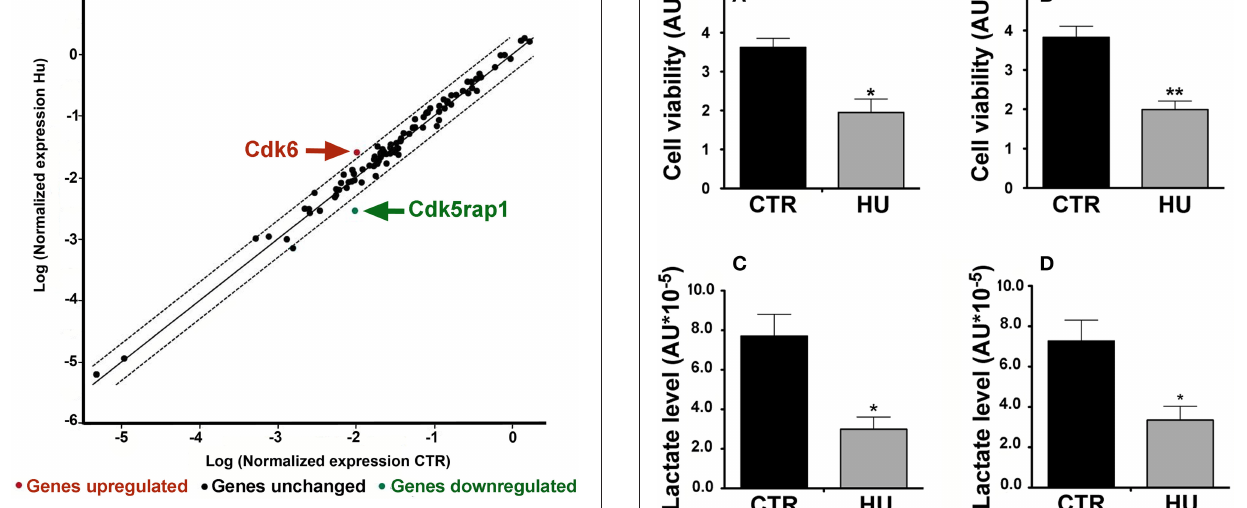
FIGURE 6 | Metabolic activity of HU and CTR NSCs. MTT Assay. (A) Cell viability expressed in arbitrary units (AU) after one day of in vitro culture * p < 0.0364. (B) Cell viability expressed in AU after three days of in vitro culture ** p < 0.0017. Black = CTR; gray = HU. (C) Lactate level: Relative lactate production expressed in AU *10 − 5 , 4h of in vitro culture * p < 0.0142. (D) Relative lactate production expressed in AU *10 − 5 , 18h of in vitro culture * p < 0.0275. Black = CTR; gray =